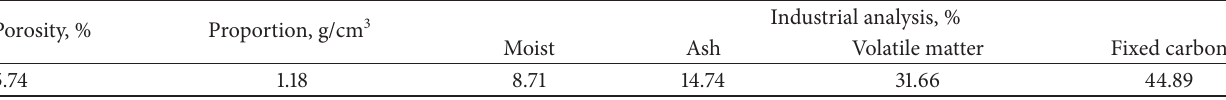
Table 1: Industrial analysis of coal sample.